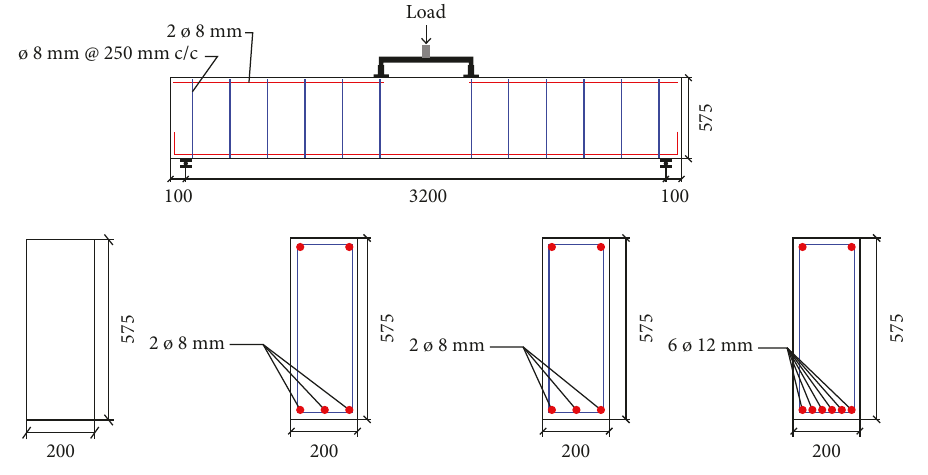
Figure 7: Medium beams reinforcement detail.